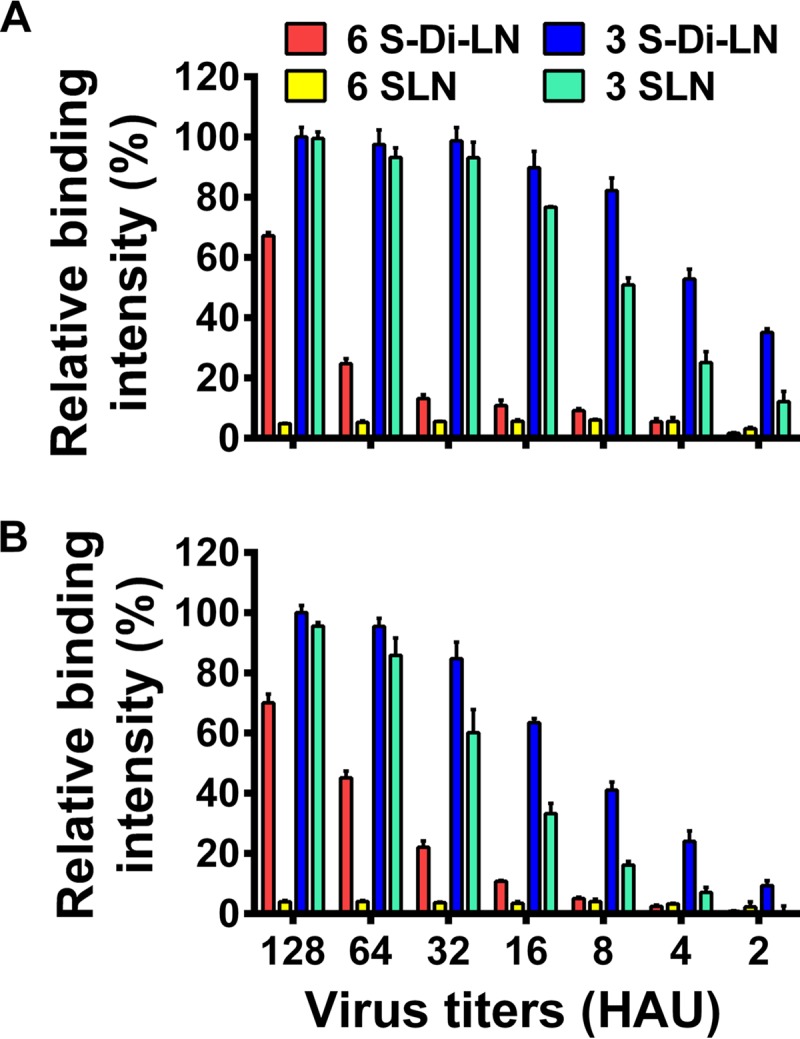
Glycan binding specificity of H5N1 viruses. The receptor specificity of influenza virus was analyzed by using a direct solid-phase assay as described previously (54). Two α-2,6 glycans, Neu5Aca2-6Galb1-4GlcNAcb-SpNH-LC-LC-biotin (6 SLN) and Neu5Aca2-6[Galb1-4GlcNAcb1-3]2b-SpNH-LC-LC-biotin (6 S-Di-LN), and two α-2,3 glycans, Neu5Aca2-3Galb1-4GlcNAcb-SpNHLC-LC-biotin (3 SLN) and Neu5Aca2-3[Galb1-4GlcNAcb1-3]2b-SpNH-LC-LC-biotin (3 S-Di-LN), were used. (A) CK/1180 virus. (B) CK/1214 virus.